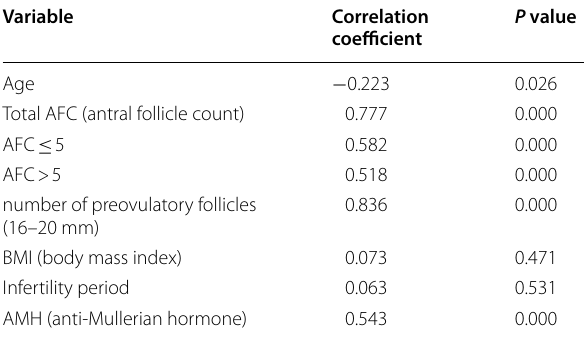
Table 4 Correlation among number of metaphase II (MII) oocytes retrieved and other related variable Variable Correlation coefficient